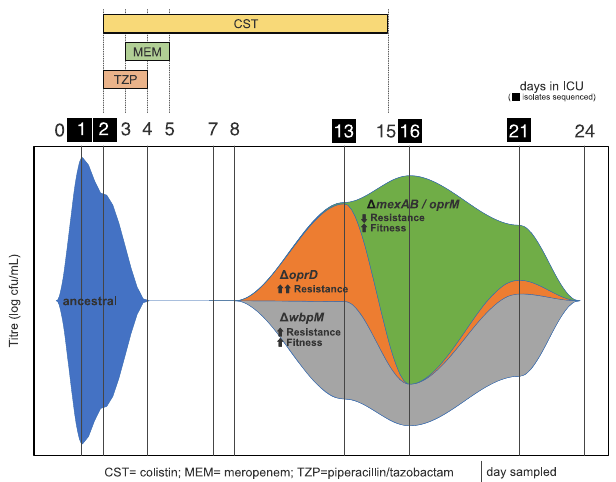
Fig. 6 Summary of bacterial dynamics during infection. This Muller plot summarizes changes in the density and composition of the lung population of P. aeruginosa during infection and it highlights the key phenotypic effects of observed mutations. This plot does not represent the reduction in the copy number of the p110820 plasmid during infection (Fig.